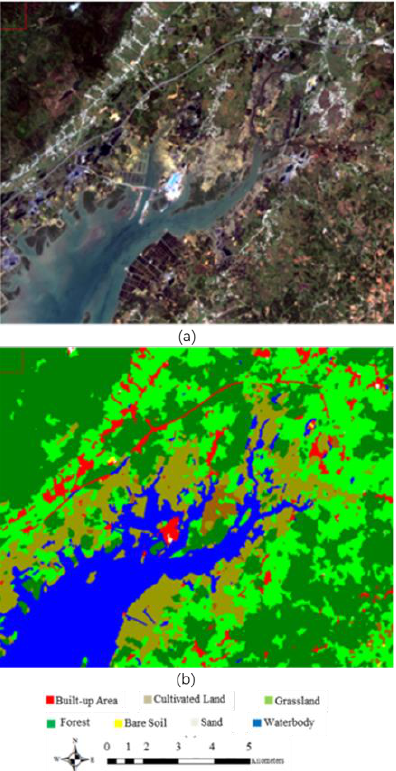
Figure 7. Clips of land cover extraction results for Beibuwan Gulf seagulf area in